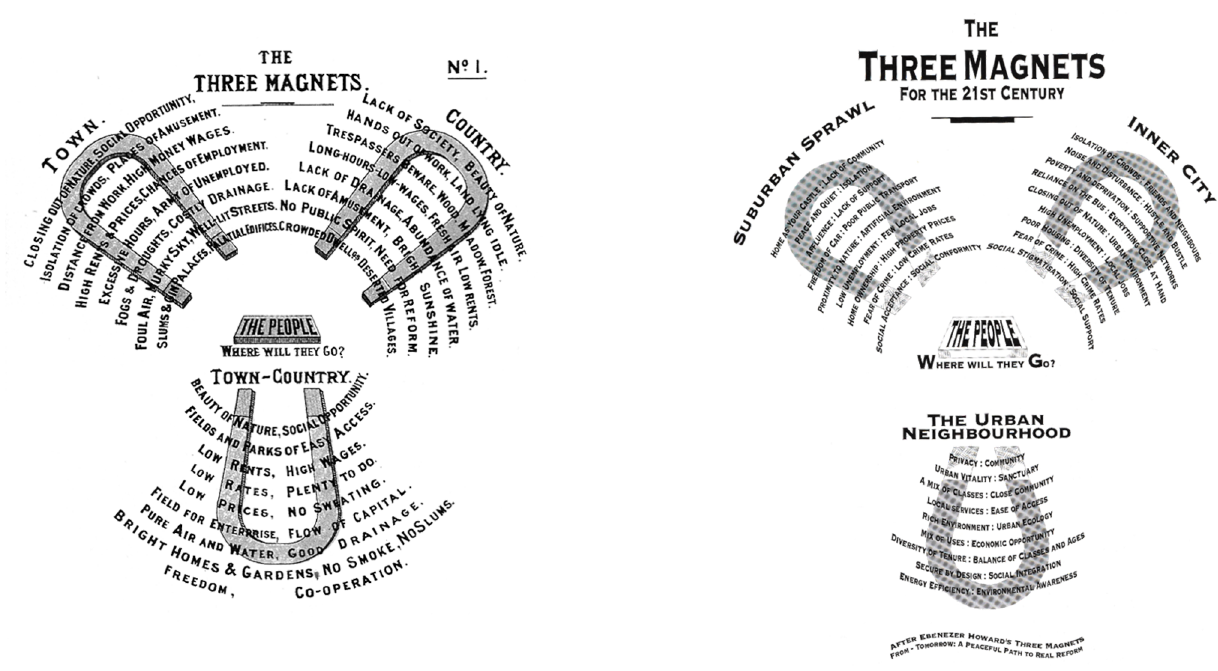
Figure 4. Howard’s Three Magnets (left) and URBED’s Three Magnets for the 21 st century (right). Sources: Howard (1898); Rudlin & URBED